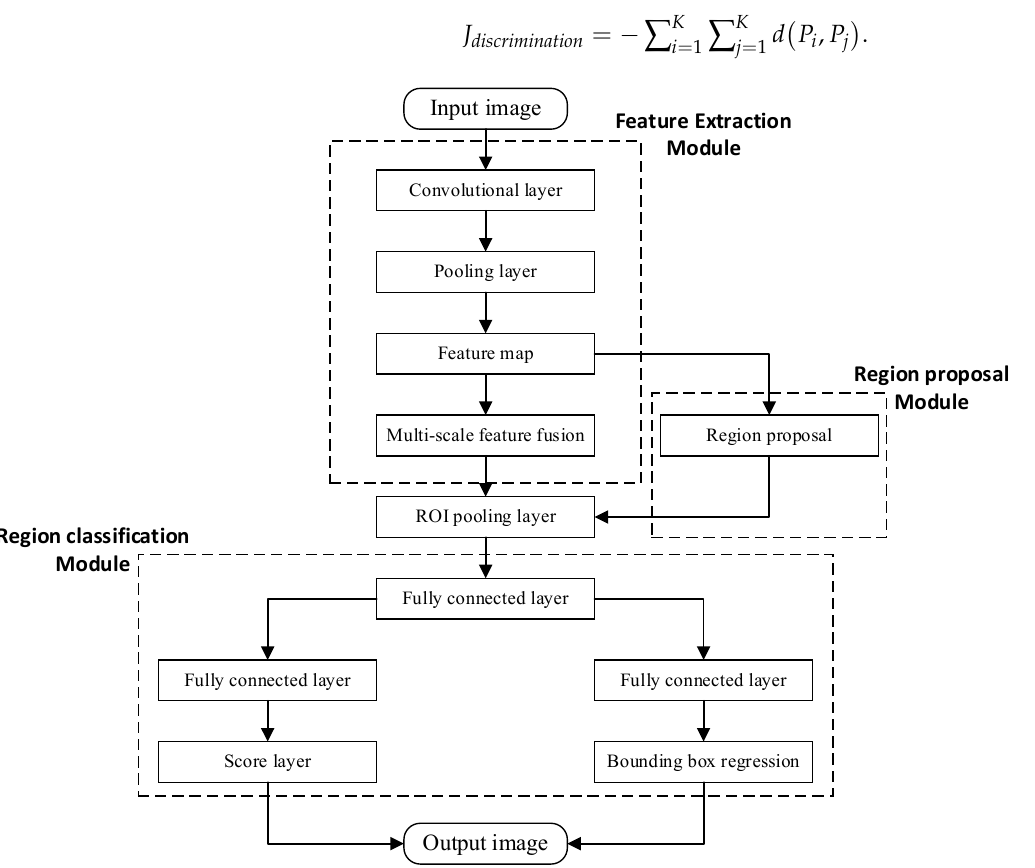
Figure 3. The architecture of the multi-scale fish features detection model.